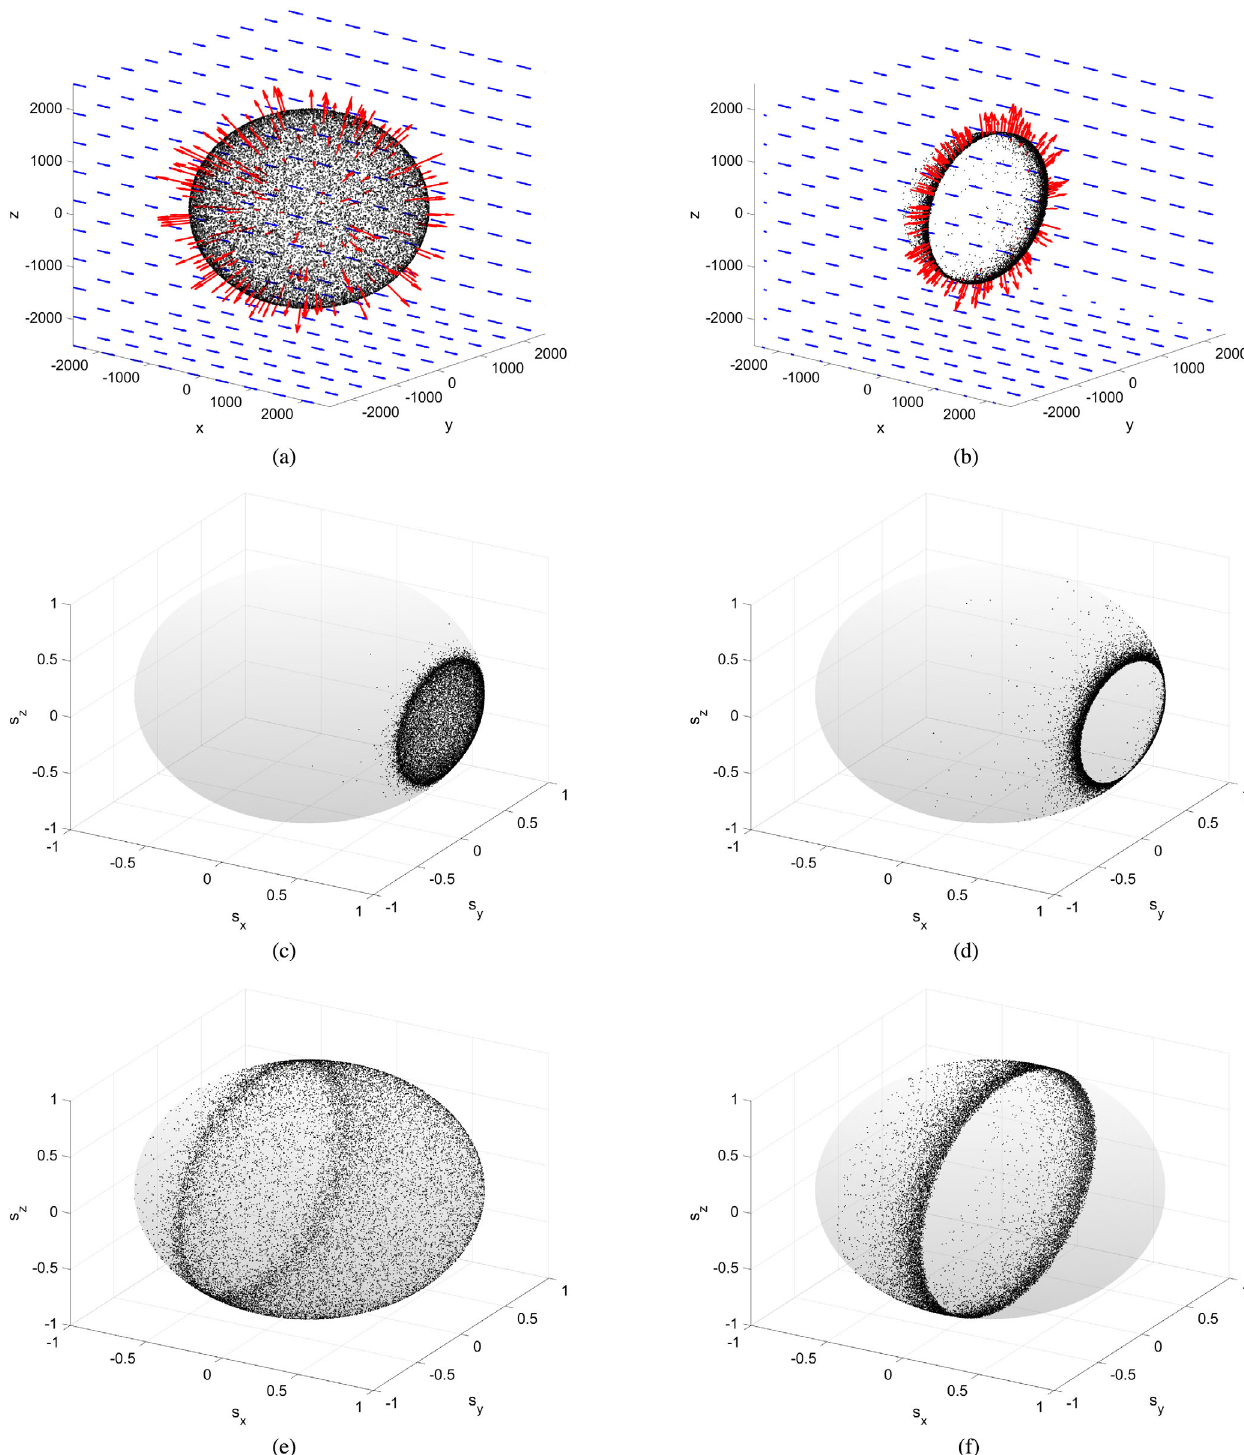
FIG. 4. A high energetic ( σ p ¼ 10 4 ) electron cloud (black dots) explodes (red arrows indicate moving direction of single electrons) in a homogeneous electric field (blue arrows) with field strength j E j ¼ E 0 , while the single particle spins distribute on the unit sphere (gray surface). Left column: The electron cloud expands radially (see red arrows) while the spins create a homogeneous covering of the unit sphere. The simulation time in 4(a) and 4(e) is t ¼ 1800 which corresponds to the depolarization time [cmp. Fig. 5(a)], while 4(c) is the spin distribution shortly after the simulation start. Right column: The electron cloud expands cylindrically (see red arrows) in a ringlike structure both in space and in spin space. The simulation time in 4(b) and 4(f) is t ¼ 1400 which again corresponds to the depolarization time [cmp. Fig. 5(a)], while 4(d) is the spin distribution shortly after the simulation